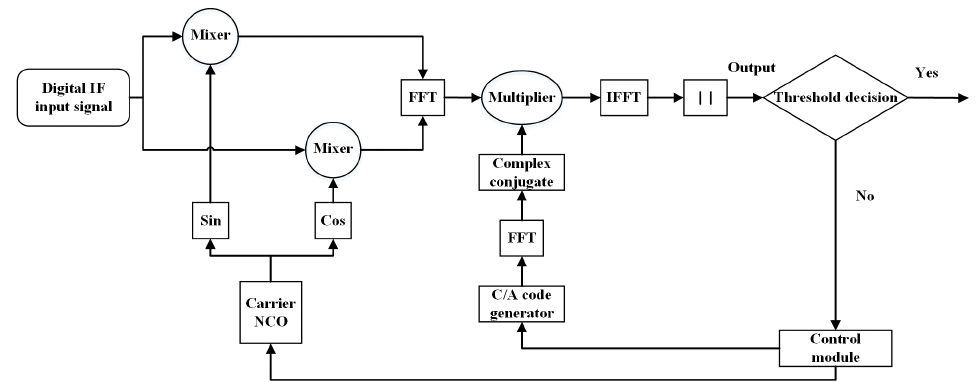
Figure 5. Parallel code phase search process.